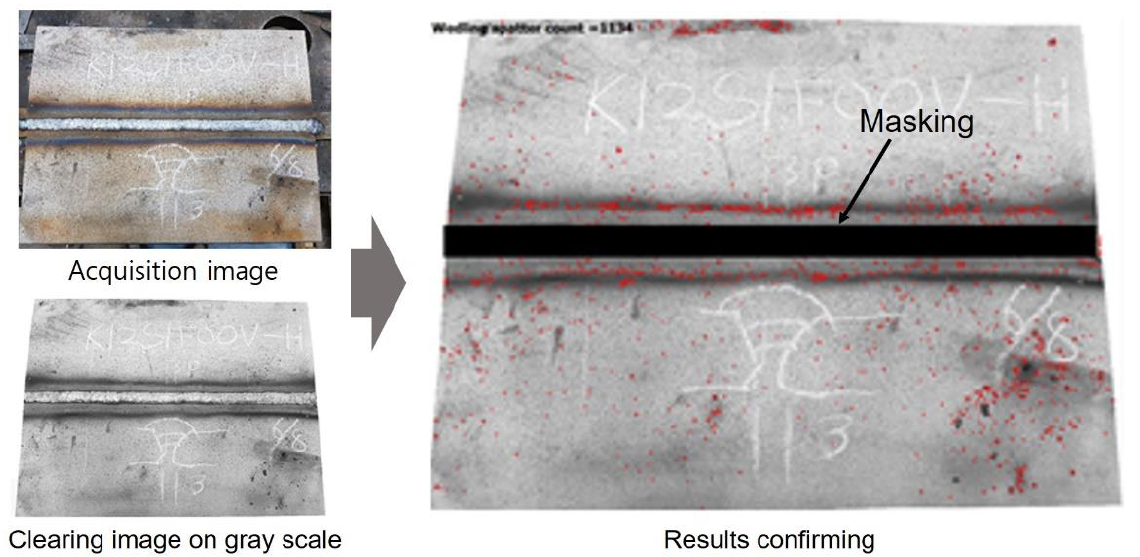
Figure 19. Weld spatter image analyses and image processing.